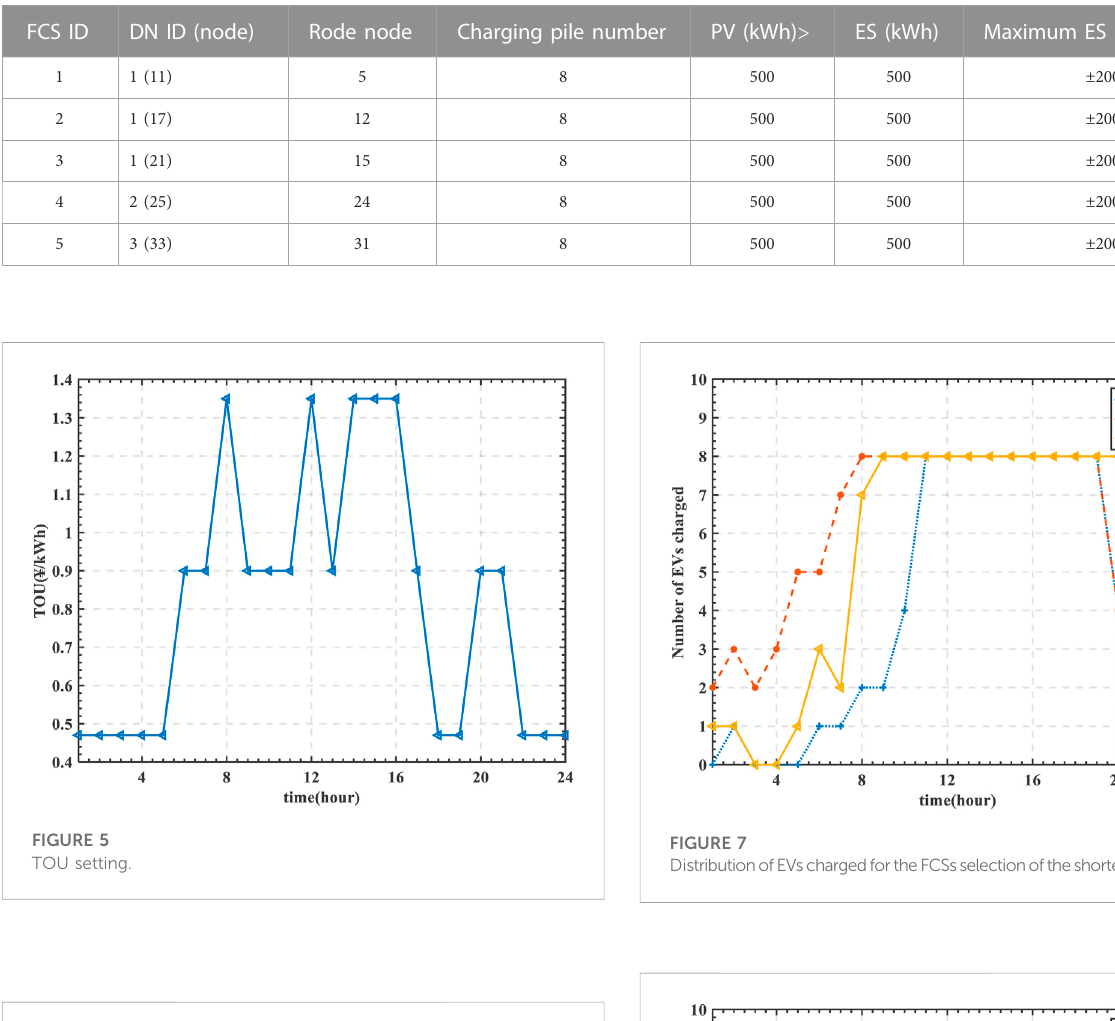
TABLE 1 Case data.